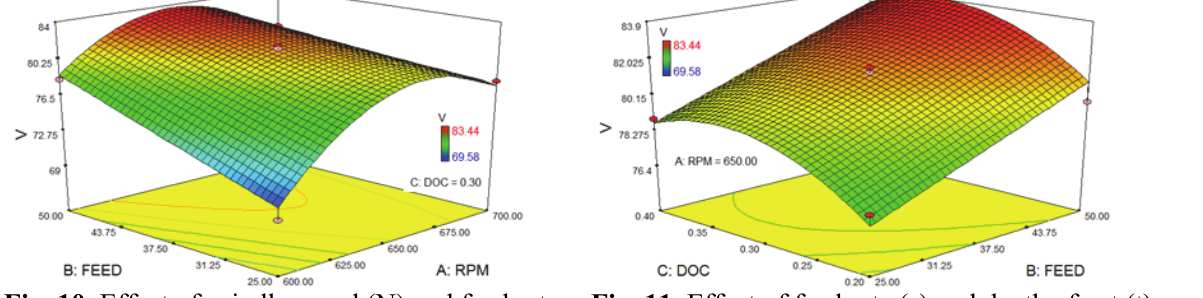
Fig. 11. Effect of feed rate (s) and depth of cut (t) on tool vibration (3-D